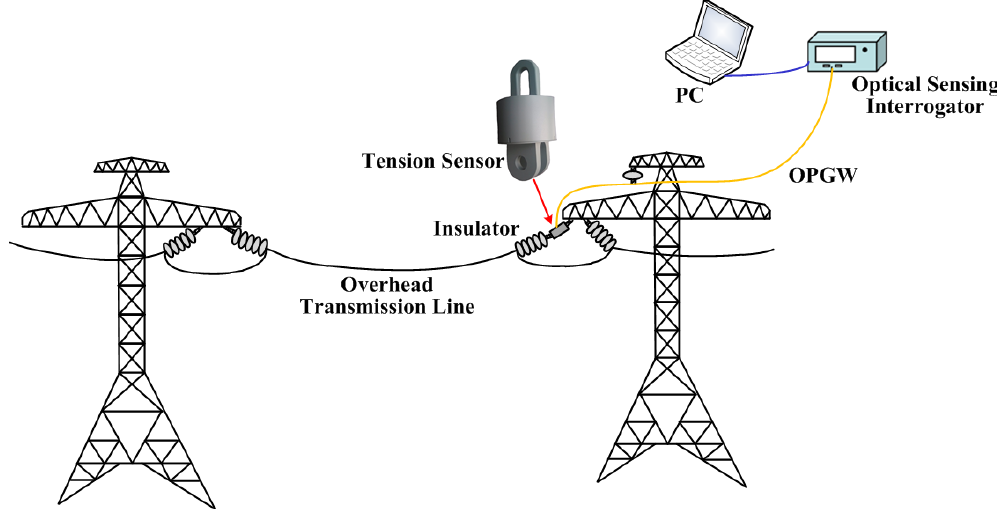
Figure 1. The mounting position of the optical tension